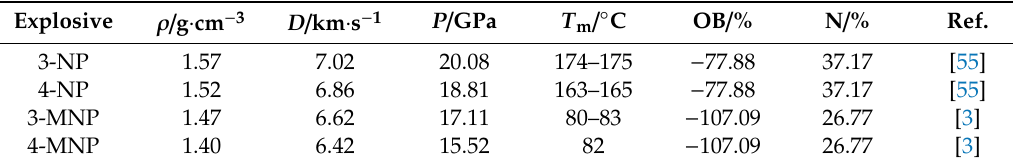
Table 1. Properties of 3-NP, 4-NP, 3-MNP and